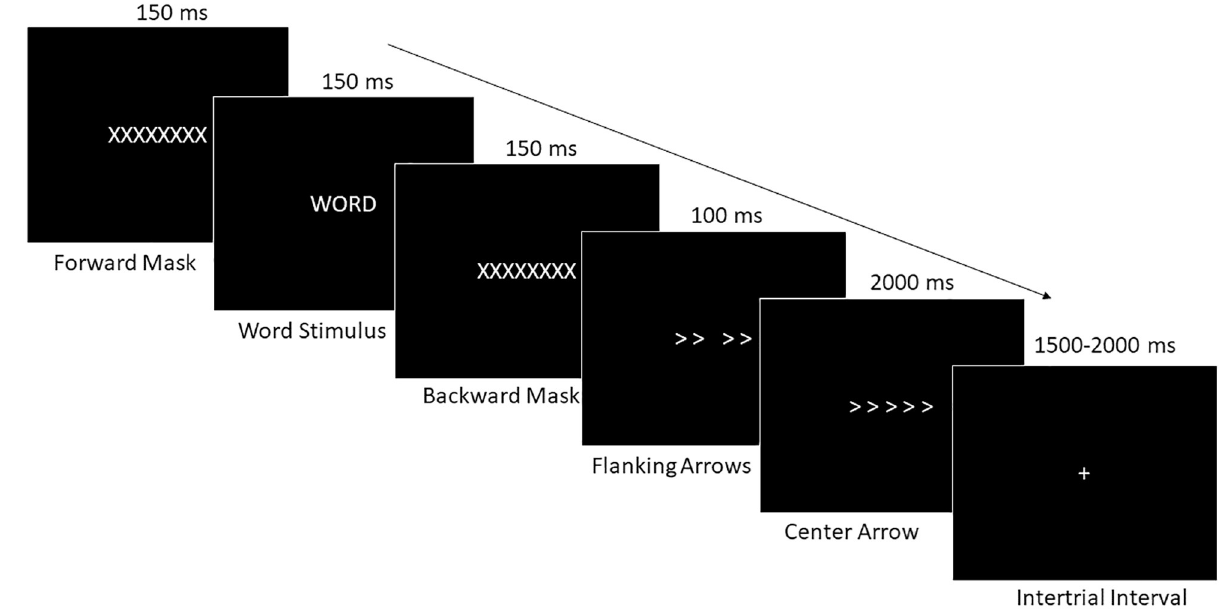
Fig 2. Timing of the emotional Flanker task. The arrow indicates the progression of time through a single trial of the Emotional Flanker